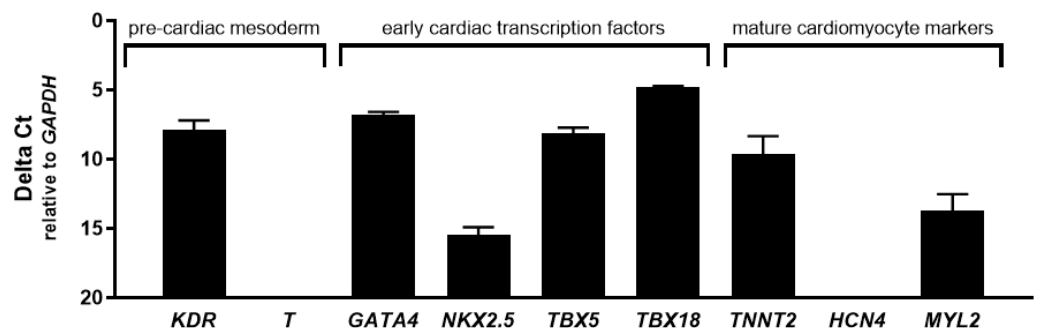
Figure 2. Early but no late cardiac differentiation markers are expressed in human cardiac atrial appendage stem cells (CASCs) during culture. Messenger RNA (mRNA) expression of KDR and T (pre-cardiac mesoderm); GATA4 , NKX2.5 , TBX5 , and TBX18 (early cardiac transcription factors); TNNT2 , HCN4 , MYL2 , and MYL7 (mature cardiomyocyte markers). Data are shown as medians ± interquartile range (IQR) ( n = 3 for individual patient CASC cultures).